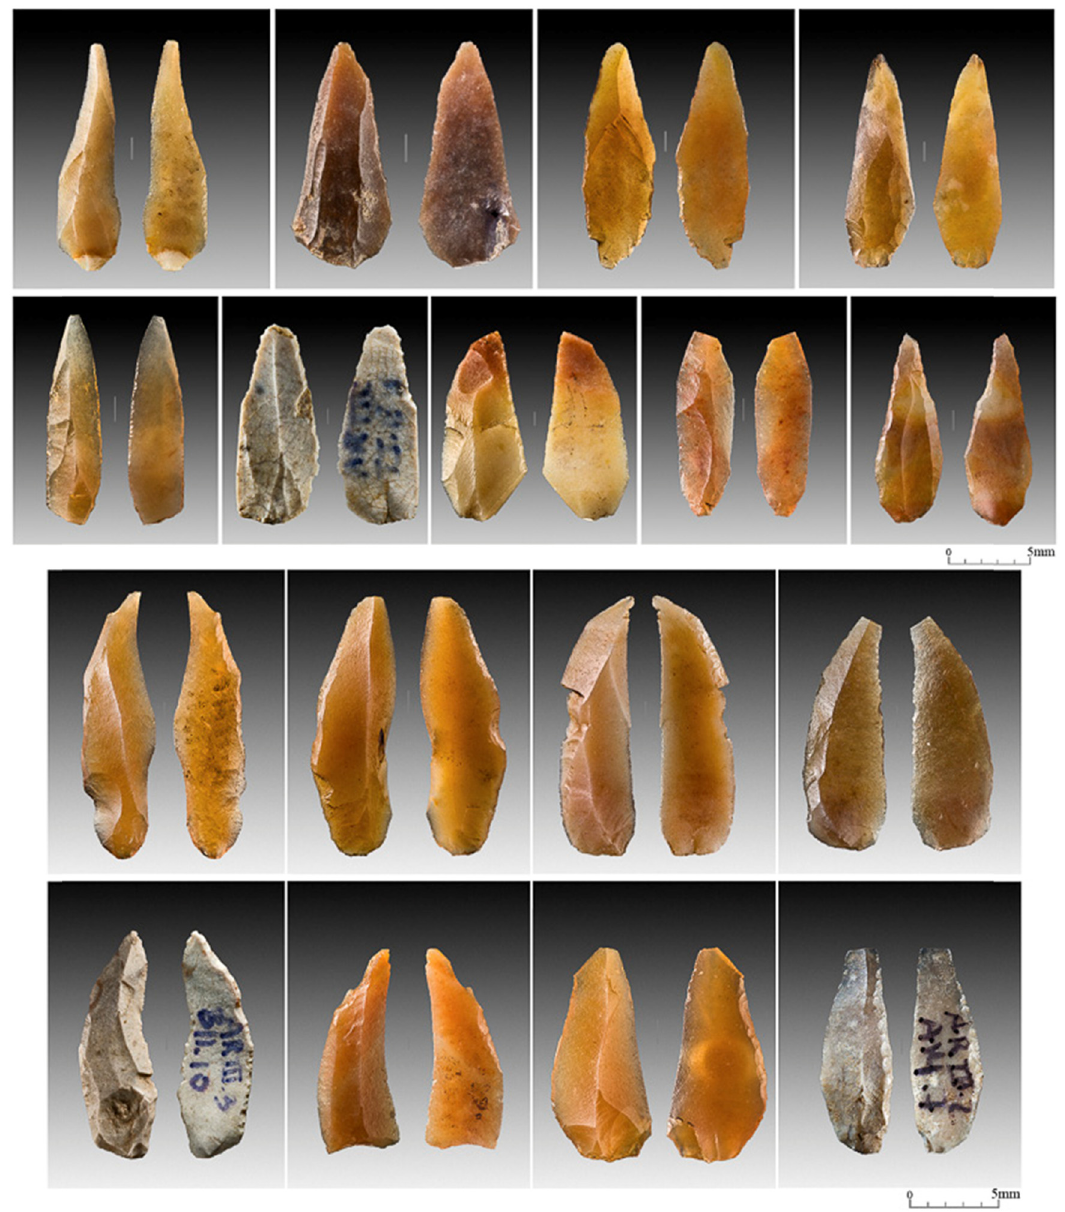
Figure 7: Areeiro 3: Areeiro bladelets. Photo J. P.